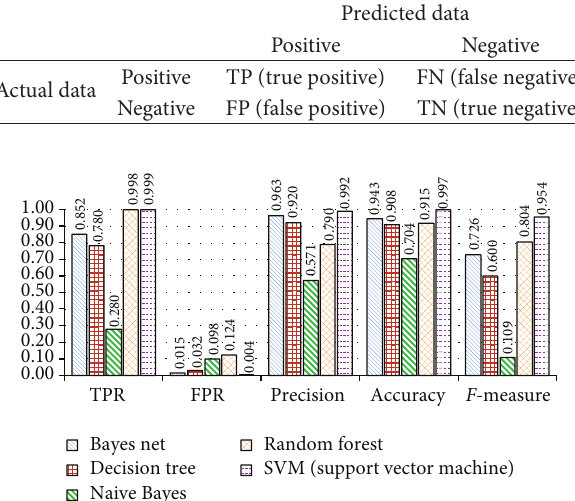
Figure 5: Composition of training and test data set.